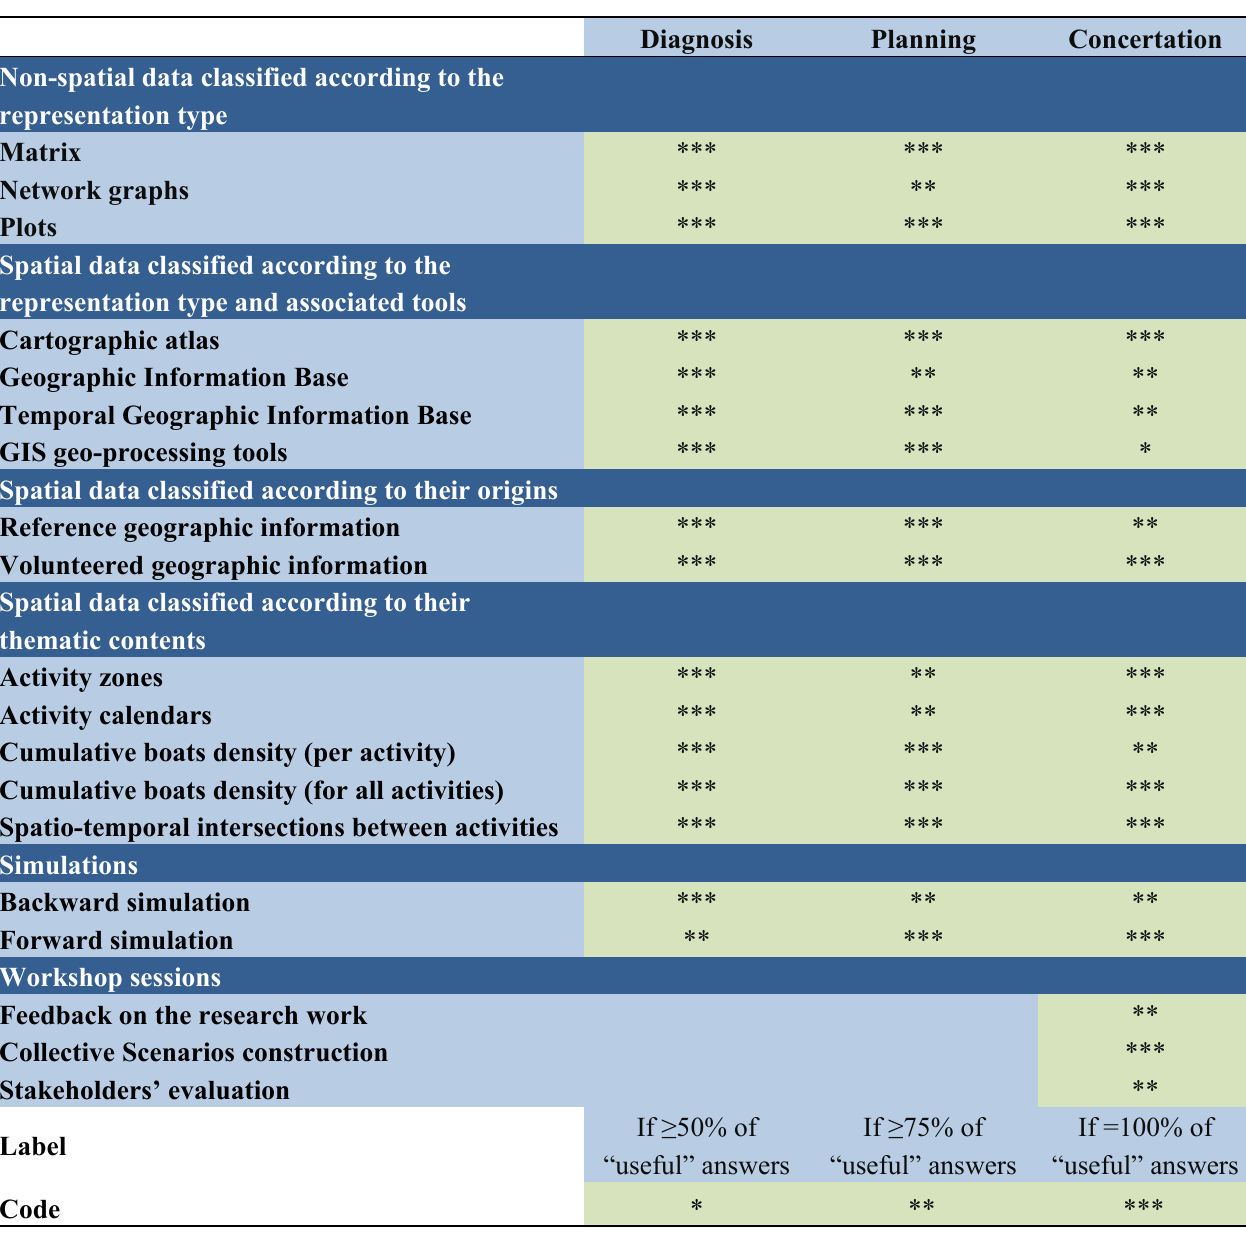
Table 3. Synthesis of stakeholders’ responses to the